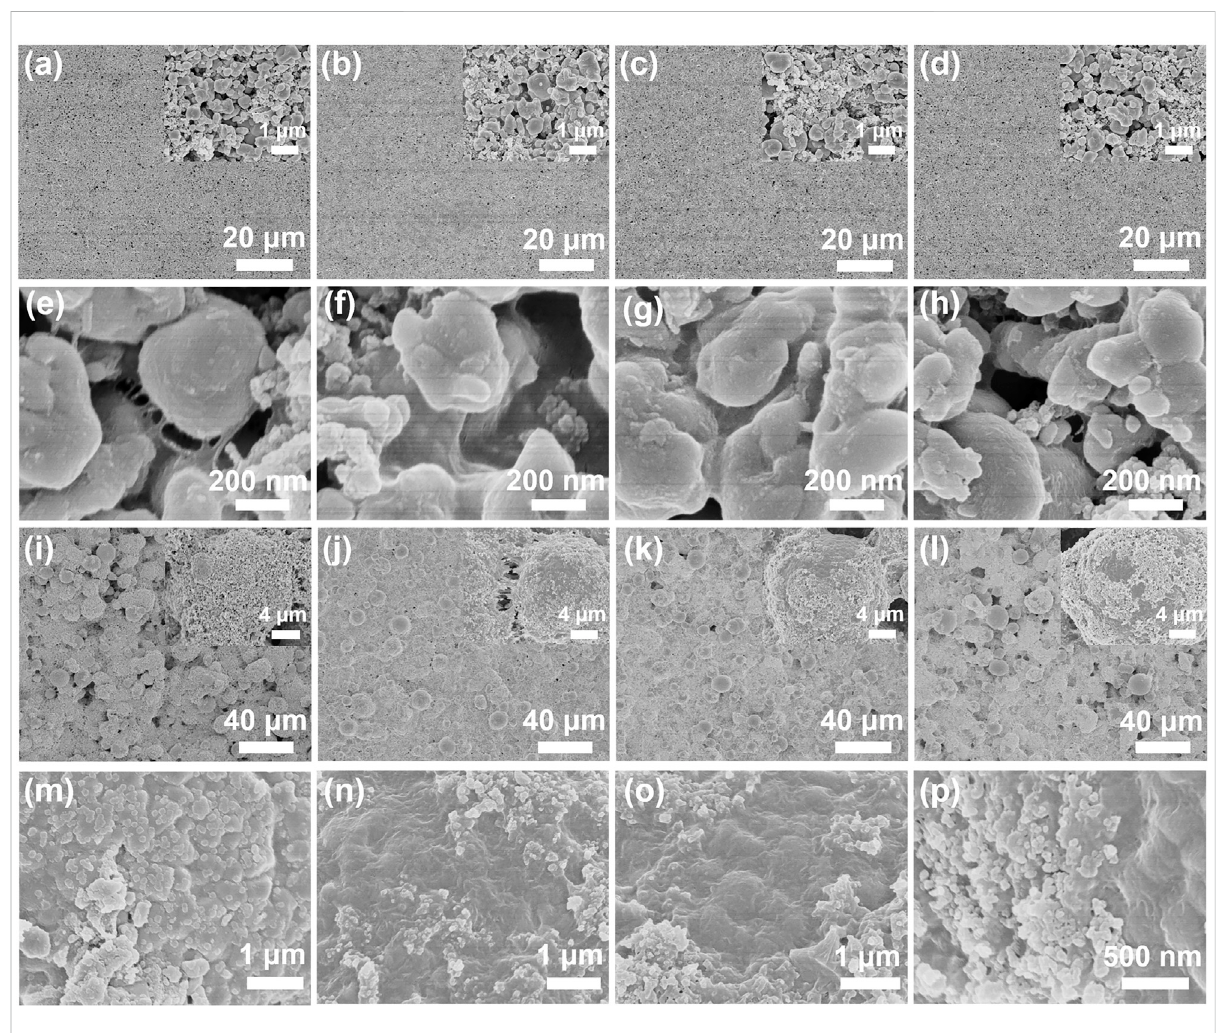
performance. The test results of NCM811 material are shown in Figure 5B, but the speci fi c surface area and porosity information of NCM-5 and NCM-0 are not obviously different, which may be related to the larger particle diameter of this